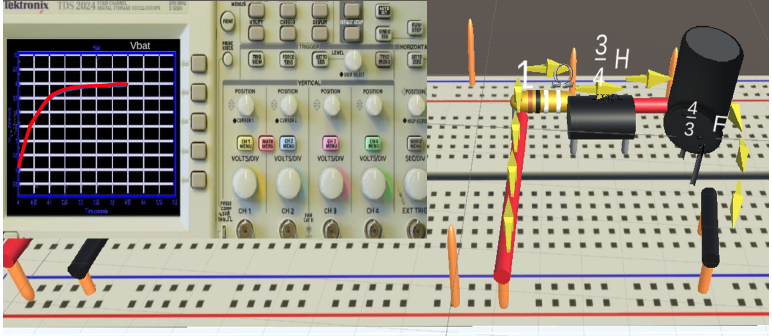
Figure 7. AR − RLC circuit GUI to assemble devices on an electronic breadboard.